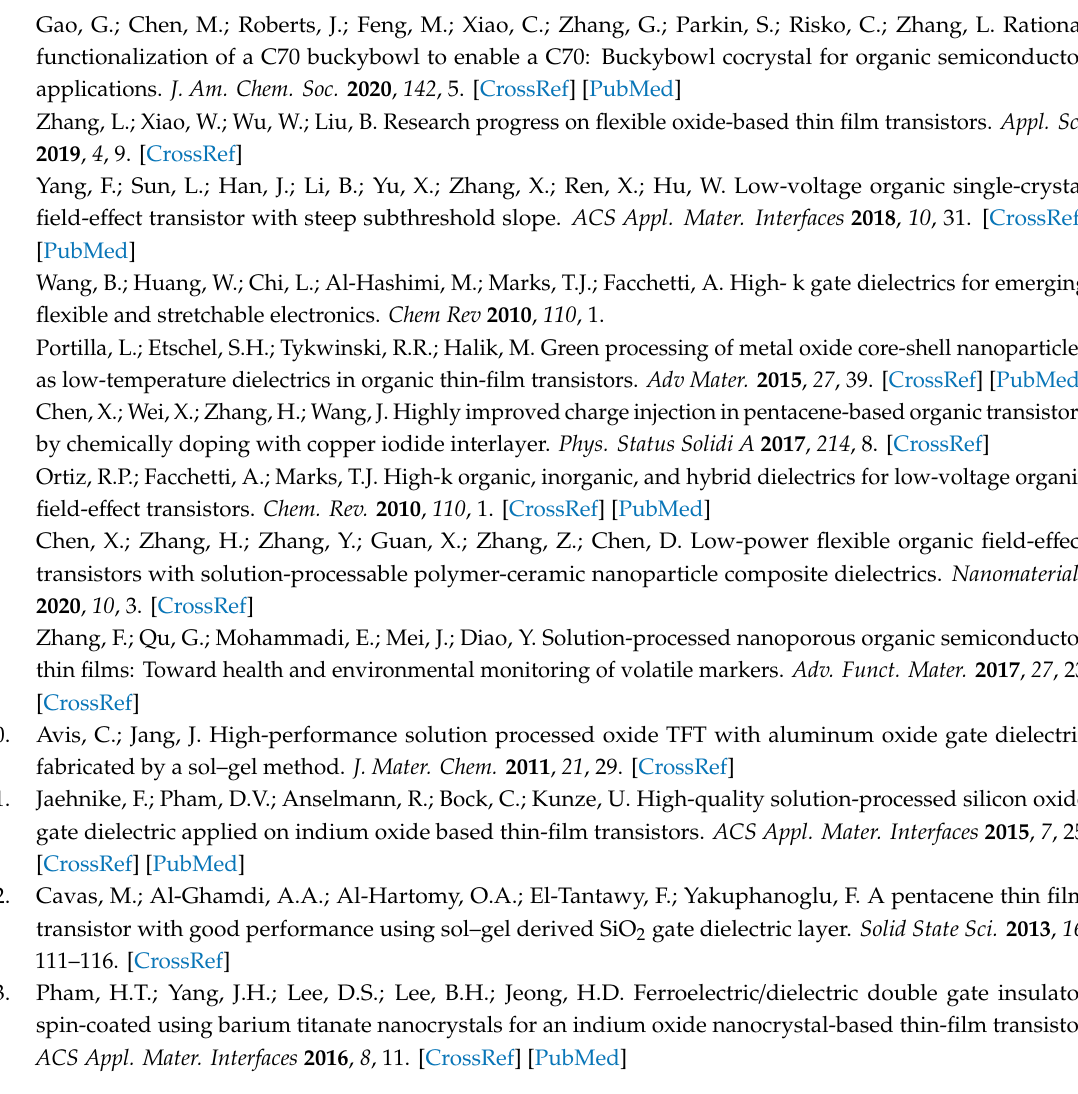
Figure S1: The leakage current of the OTFTs based on various dielectric layer by applying the gate voltage from 1 to − 5V; Figure S2: The hysteresis characteristic of OTFT device with improved Sol-gel SiOx / PVP dielectric layer; Figure S3: The normalized D / S current of OTFT device with improved sol–gel SiOx / PVP dielectric layer when constant bias stress V GS = − 5V is applied for more than 3